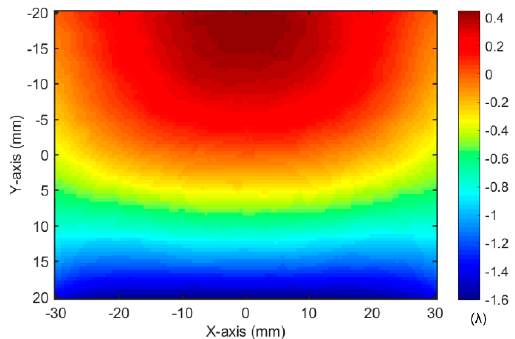
Figure 10. Total wavefront aberrations in laser amplifier.